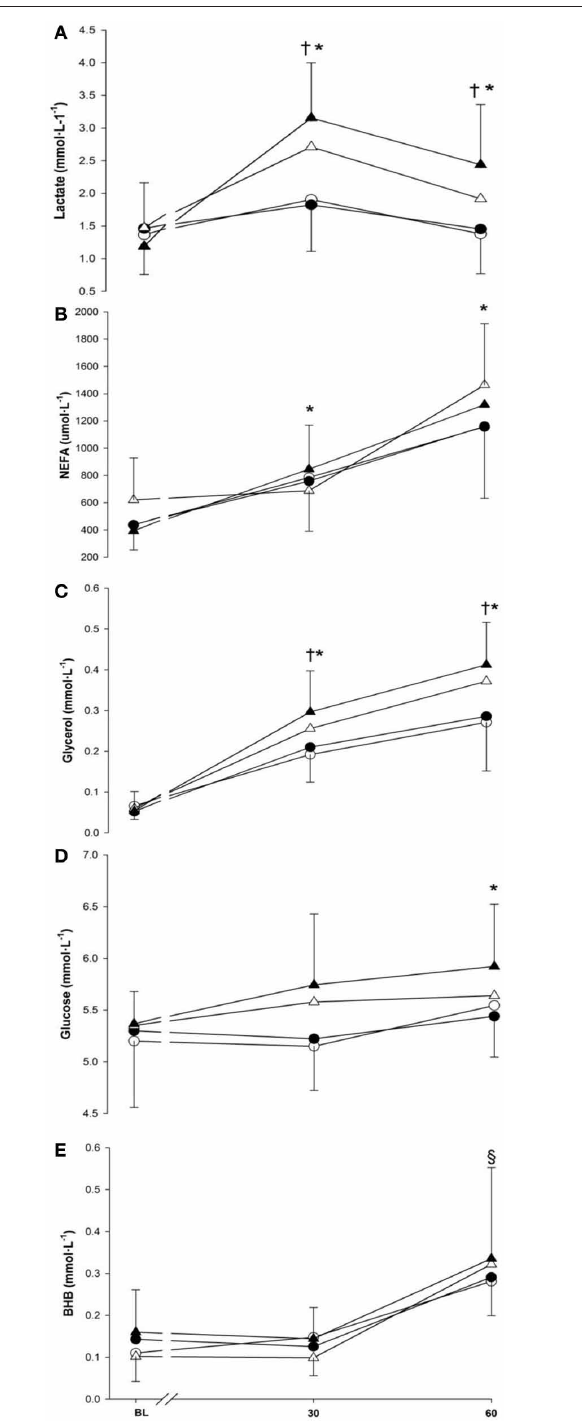
FIGURE 5 | Lactate (panel A), non-esterified fatty acids (panel B), glycerol (panel C), glucose (panel D) and beta-hydroxybutyrate (panel E) at baseline (BL) and during 60-min of exercise during walking ( (cid:2) and • ) and running ( (cid:2) and (cid:2) ), in cold ( (cid:2) and (cid:2) ), and neutral ( • and (cid:2) ) ambient temperatures. Mean ( ± SD). † Significant difference between walking and running ( P < 0 . 01). ∗ Significantly greater than baseline ( P < 0 . 05). § Significantly greater than baseline and 30min ( P < 0 .